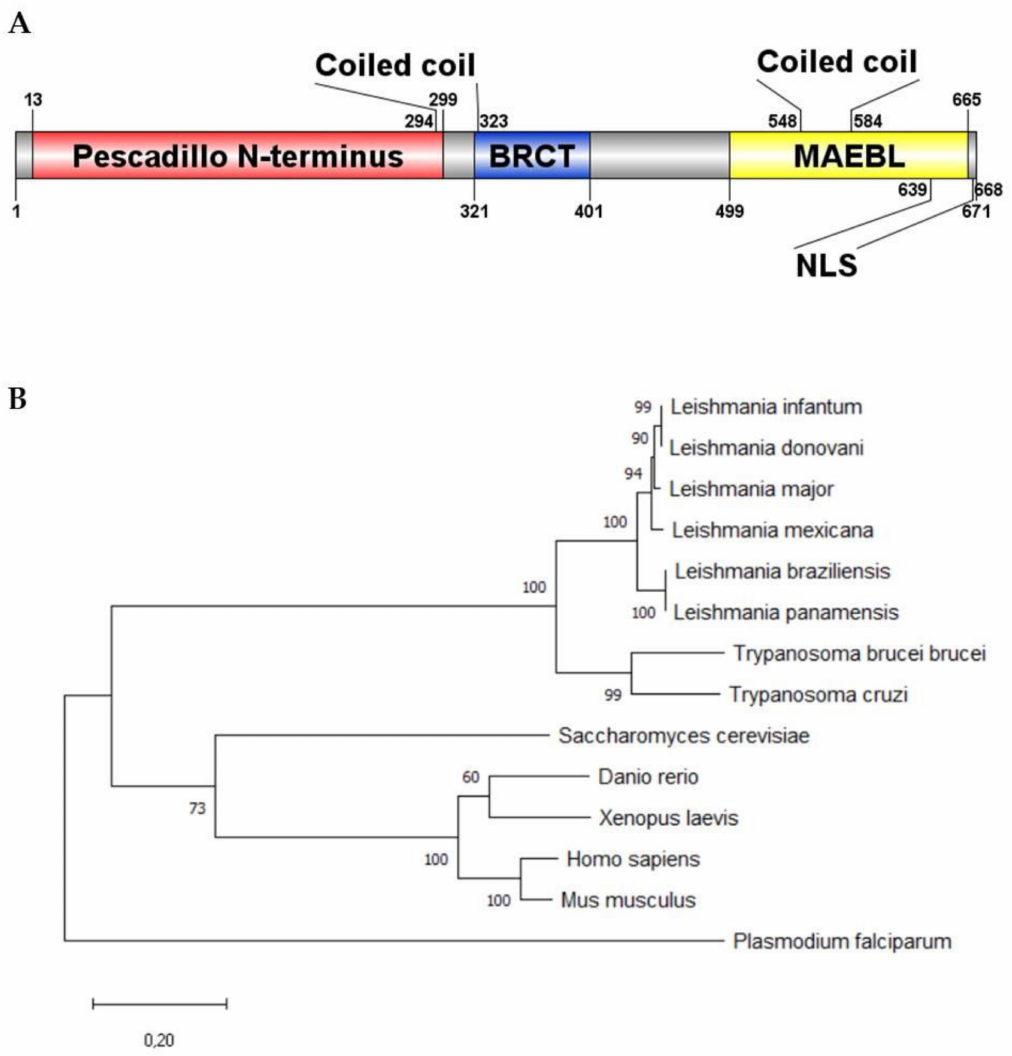
Figure 1. LmjPES is highly conserved among trypanosomatid cluster. ( A ) Schematic representation of the predicted catalytically relevant regions and domains of LmjPES. ( B ) Phylogenetic analysis of LmjPES. Tree was rooted using the sequence of the hypothetical protein C923_03267 from Plasmodium falciparum . Protein sequences of PES trypanosomatid orthologues (accession numbers: XP_001561761.1, XP_010703722.1, XP_003871849.1, XP_888589.1, A4HS78.1, AYU75861.1, XP_827157.1, RNF20479.1) and PES proteins form Danio rerio (NP_571105.3), Xenopus laevis (NP_001080557.1), Homo sapiens (NP_055118.1), Mus musculus (NP_075027.1) and Saccharomyces cervisiae (PJP07134.1) were used to generate the